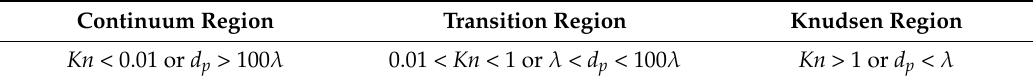
Table 1. Mass transfer models through the membrane.